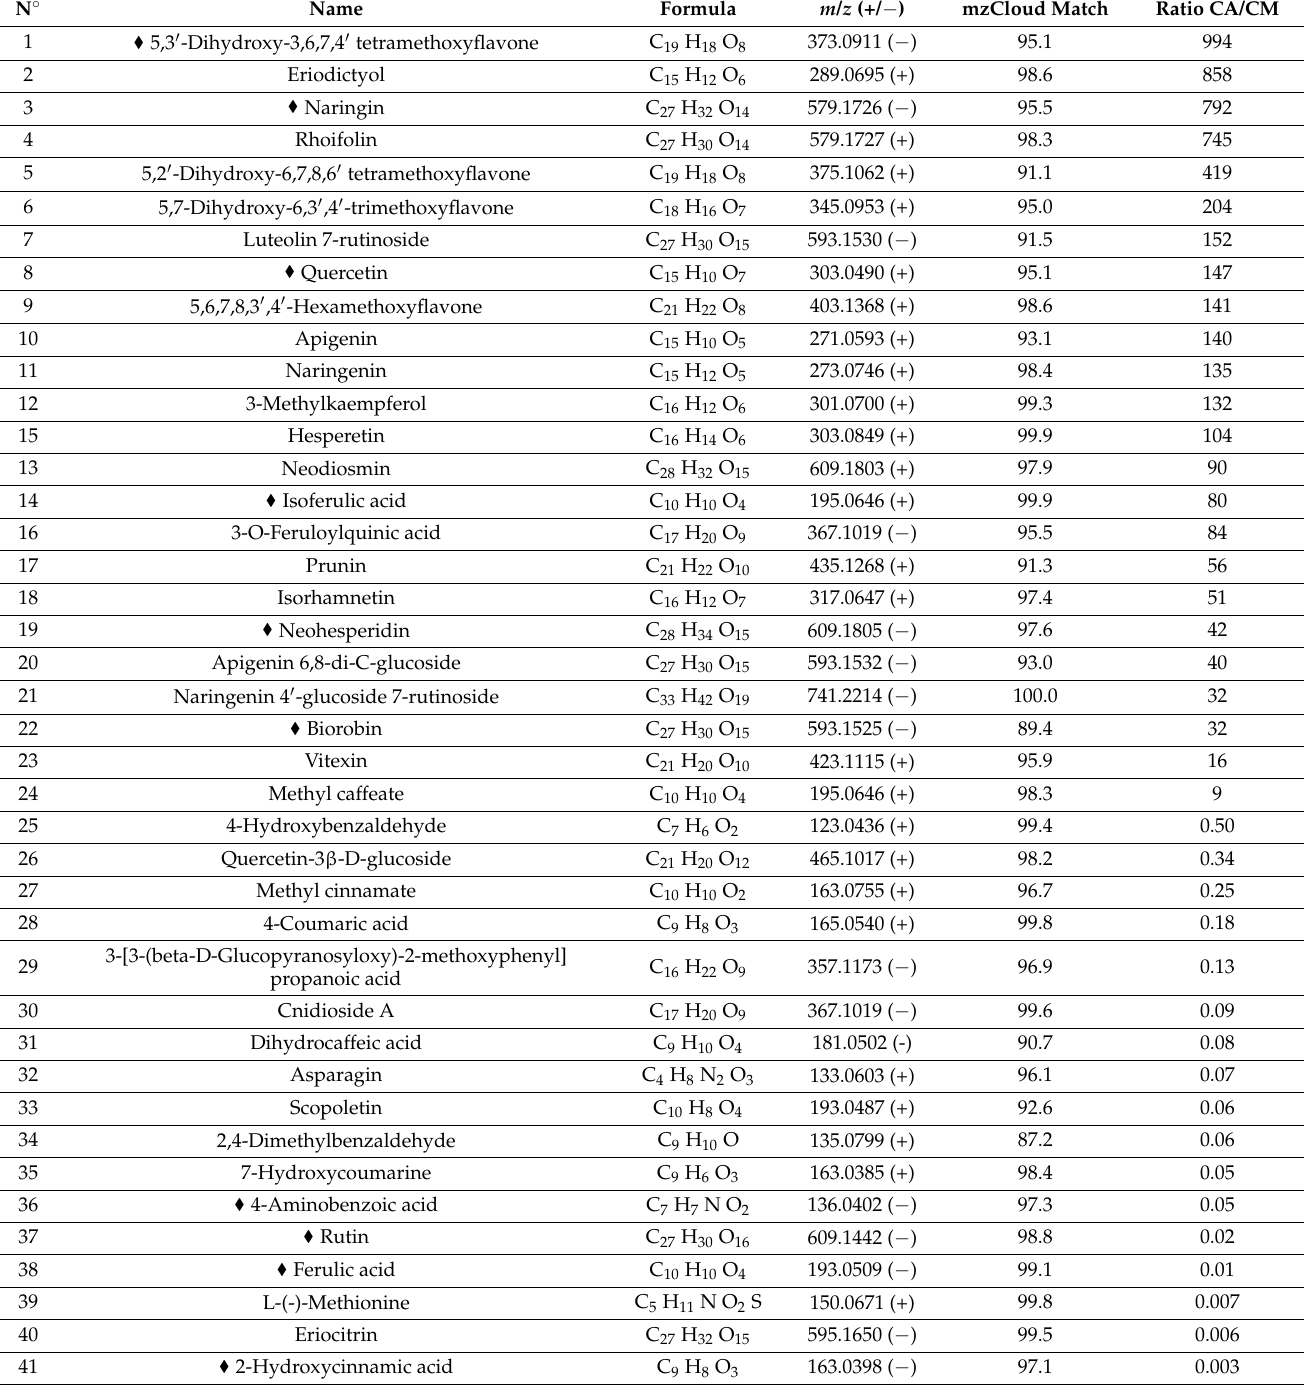
Table 1. Metabolites tentatively annotated in the phloem sap of Citrus aurantium (CA) and C. macro- phylla (CM). The ratios of annotated compounds, CA/CM, are listed in descending order. CA/CM ratio values below 0 indicate annotated metabolites are more abundant in CM. Listed compounds show mzCloud match ≥ 85% (negative or positive polarity) and p -value < 0.001. Compounds labelled with the symbol (cid:7) are also annotated in Table